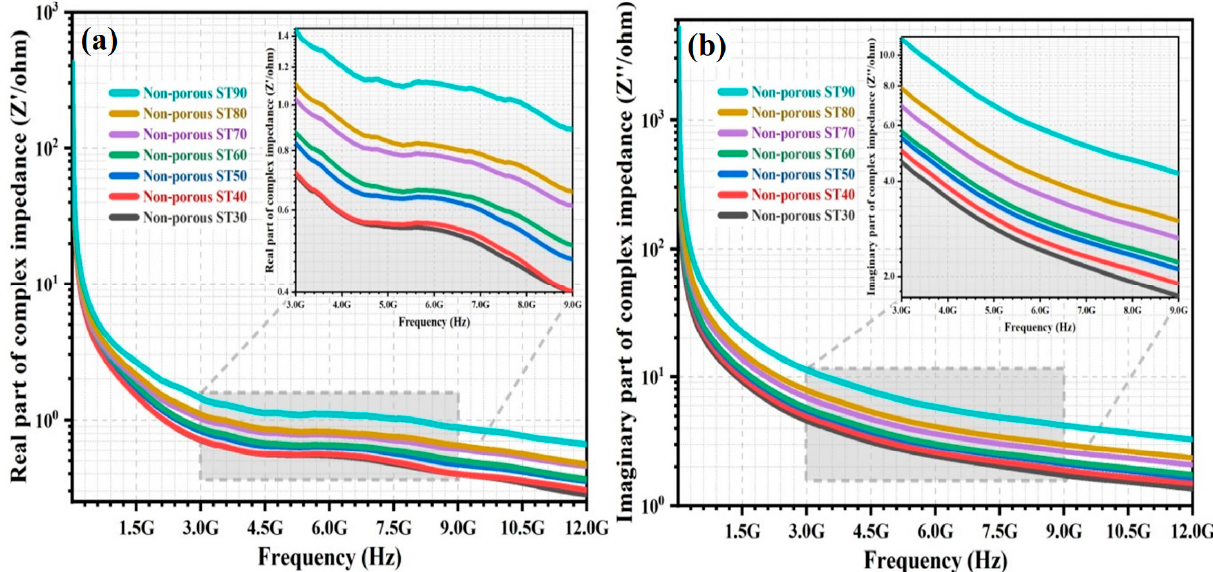
Figure 4. The variation of ( a ) Z’ and ( b ) Z ″ of non-porous HAp/ST composites over frequency.